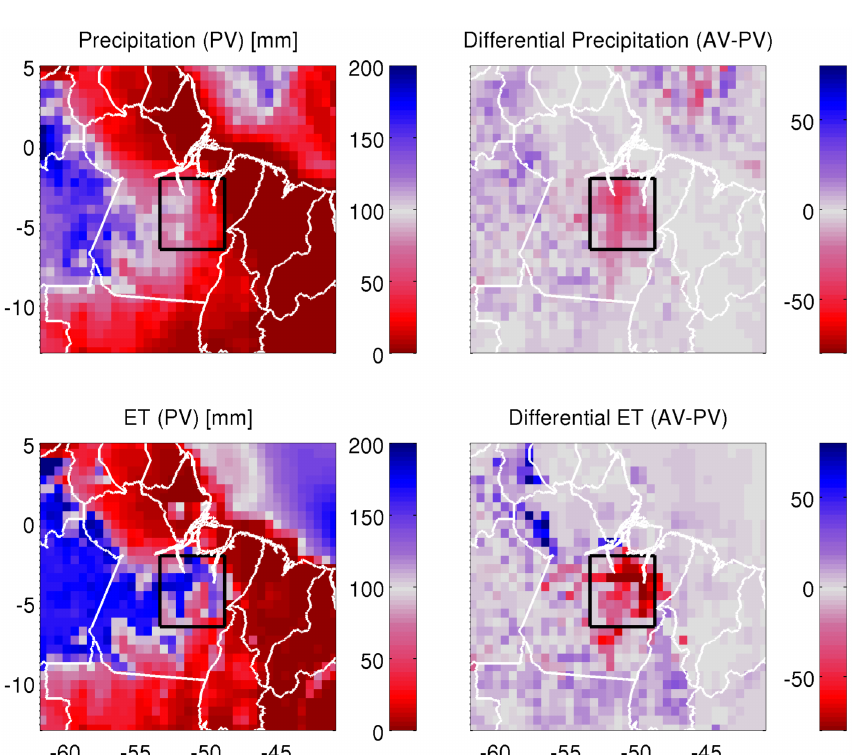
Figure 11. Monthly integrated surface water fluxes over the Pará focus region, September 2003. Upper left panel: map of integrated monthly precipitation for the potential vegetation simulation (PV). Upper right panel: map of the integrated difference in monthly precipitation, actual vegetation case minus the potential vegetation case (AV–PV). Lower left panel: map of integrated monthly evapotranspiration for the potential vegetation simulation. Lower right panel: map of the integrated difference in monthly evapotranspiration, actual vegetation case minus the potential vegetation